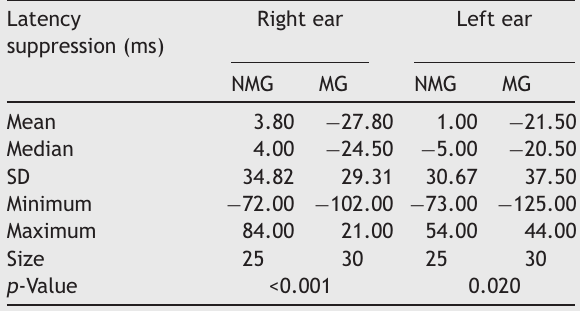
Comparison of the P300 latency suppression (ms) between the NMG and the MG for the right and left ears.